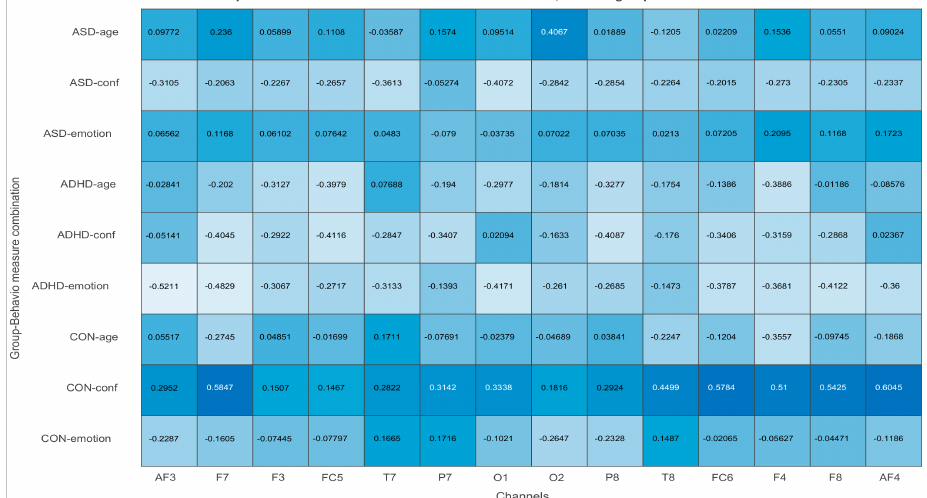
Figure 16. Heat map of the correlation matrix R between brain and behavior matrices for the valid syllogism.